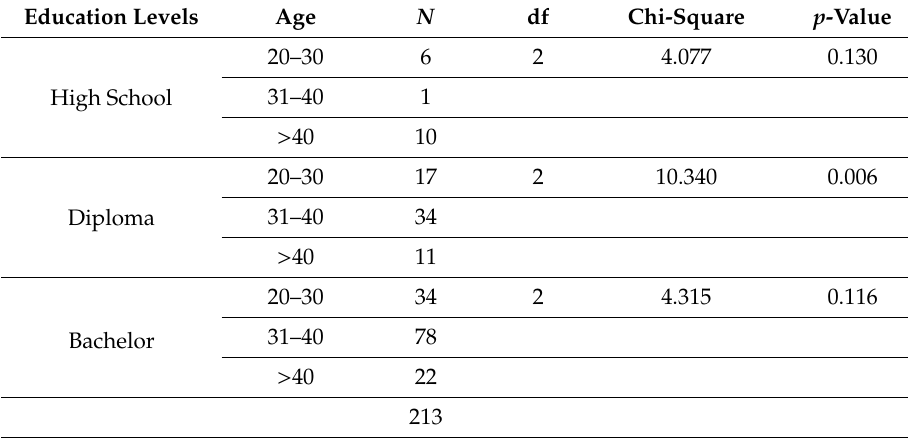
Table 8. Kruskal-Wallis Test for social belief (age with education